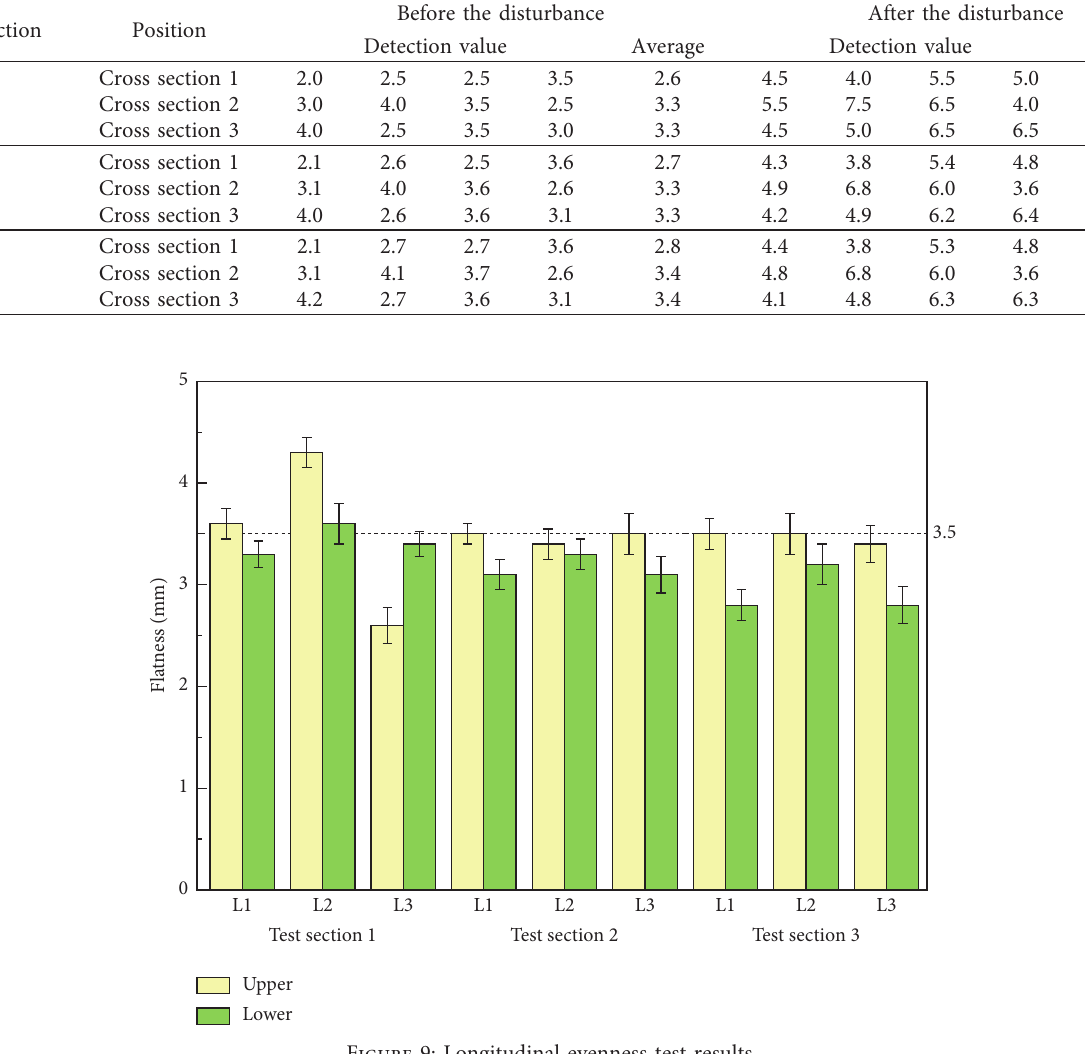
Table 7: Test results of the horizontal evenness of the lower layer (mm).